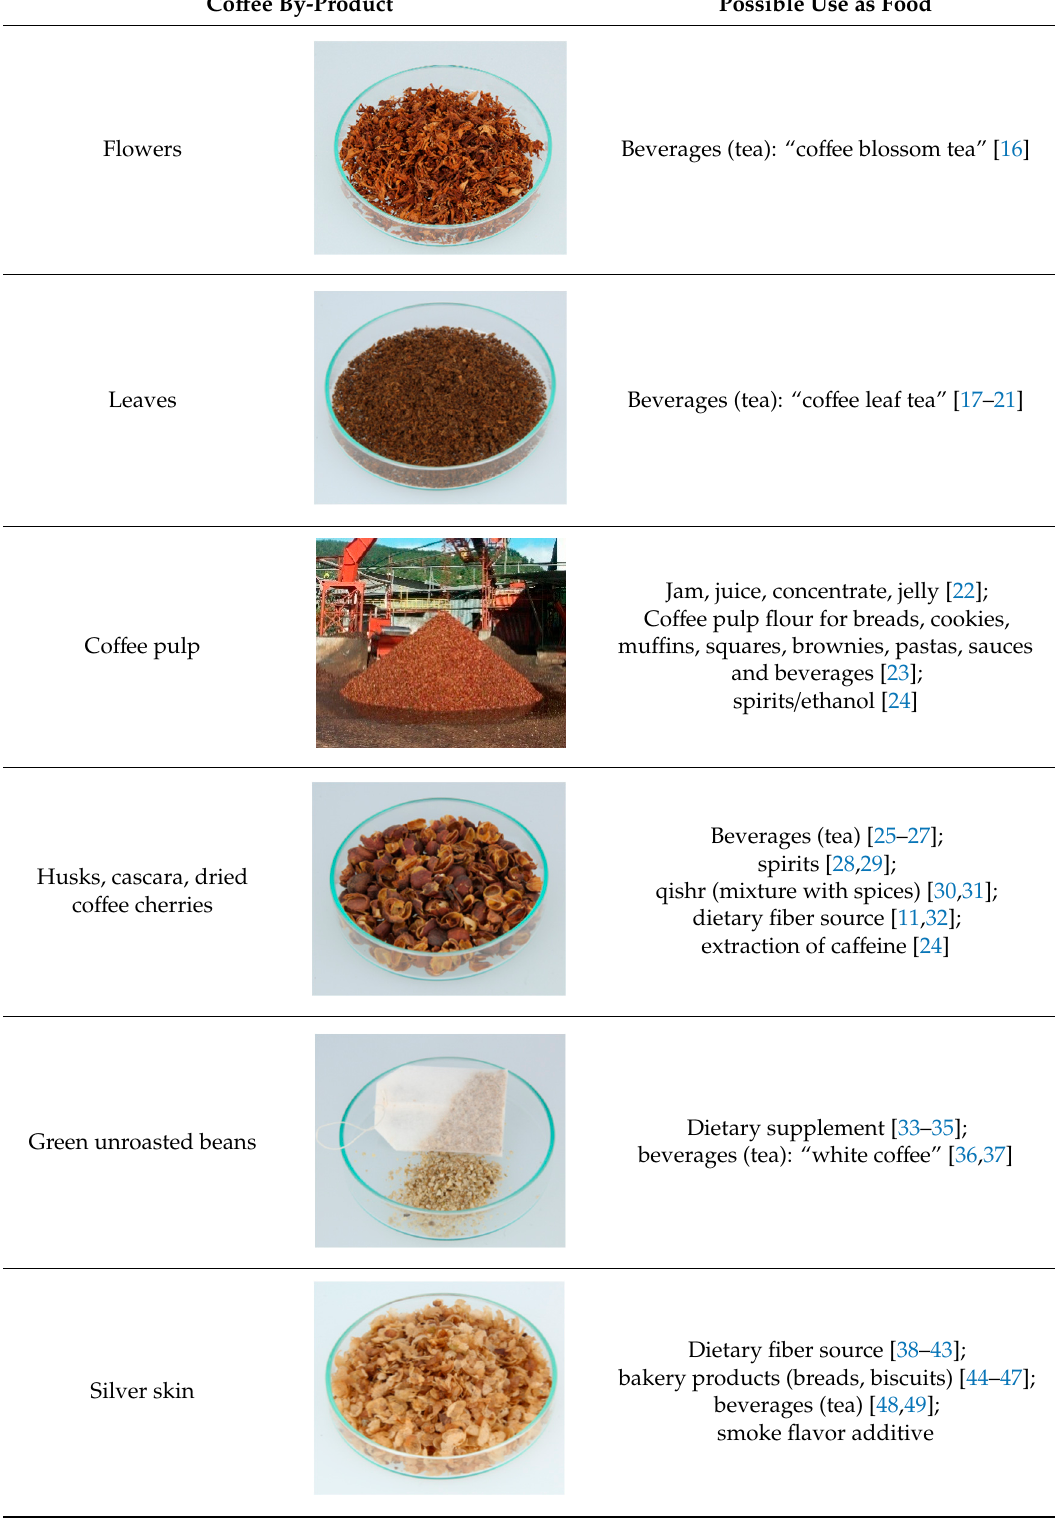
Table 1. Main uses of coffee by-products in the food sector.